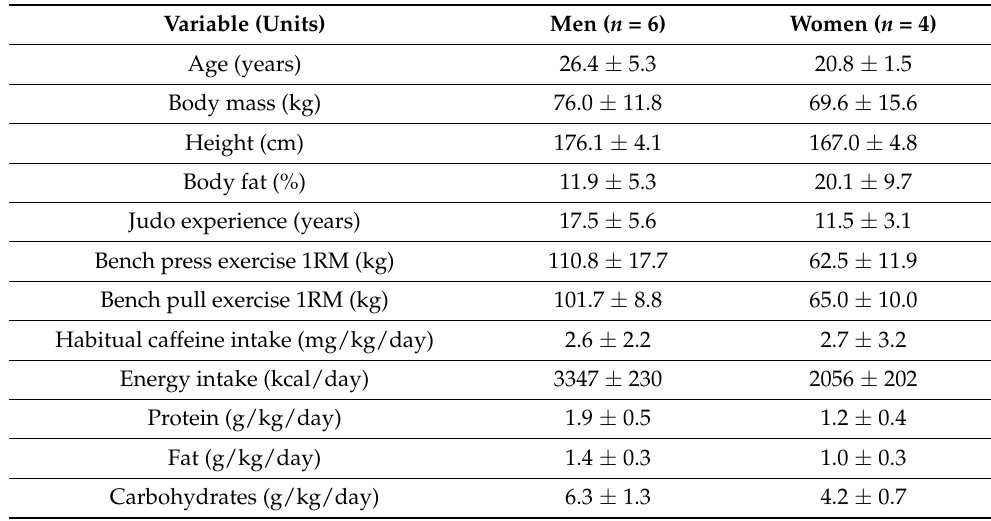
Table 1. Main participants’